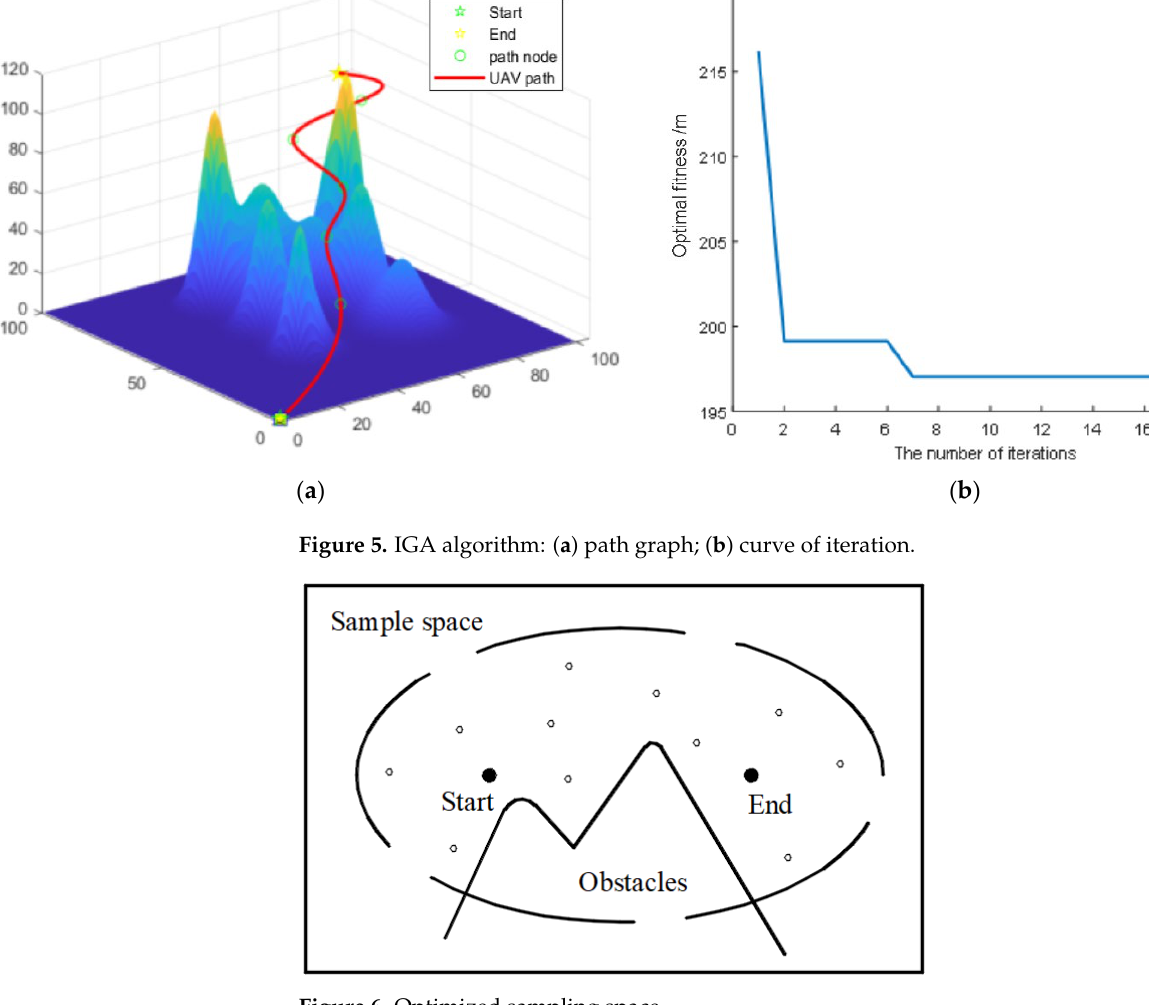
Figure 7. The effect of sampling space optimization. 4.3.2. Optimizing Corner Path In order to simulate the flight path of a UAV in the actual flight corner, this paper adopted the third-order B-spline curve method to optimize the trajectory path of the UAV. In order to ensure a certain distance between the B-spline and the obstacle, the radius of the fillet should be enlarged as far as possible, and the distance between the control points